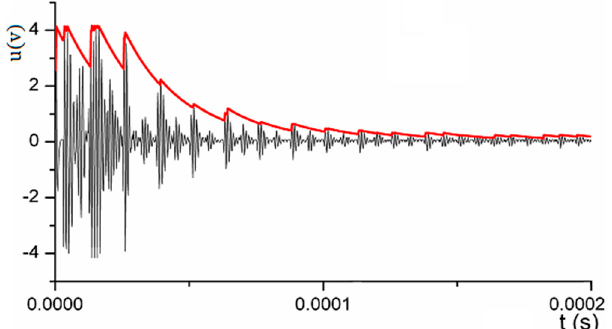
Figure 9. Original echo signal with a 10 MHz sampling and the envelope detection curve.